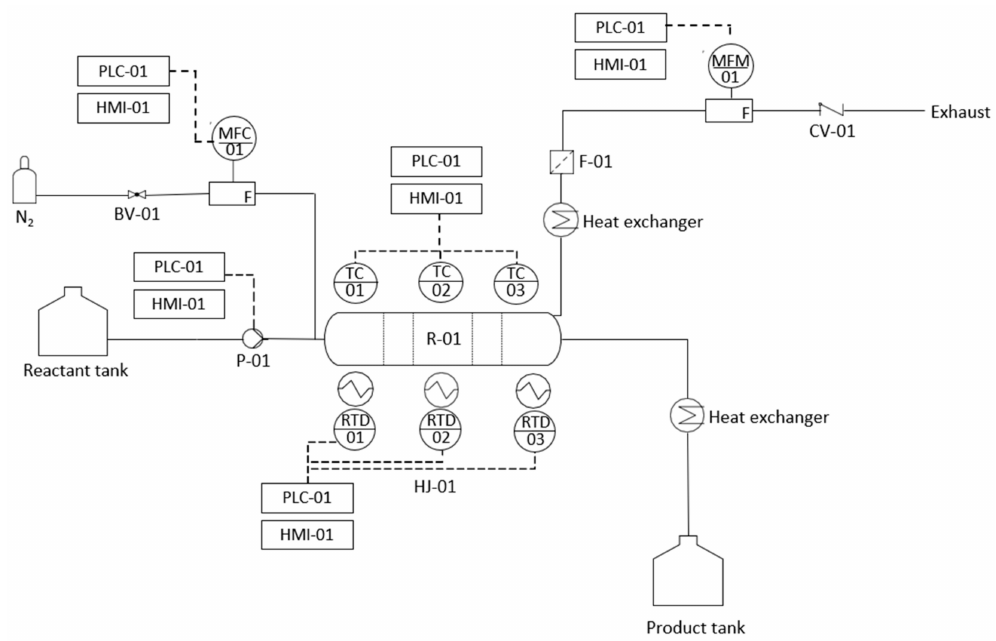
Figure 14. Process flow diagram of the fixed-bed reactor dehydrogenation